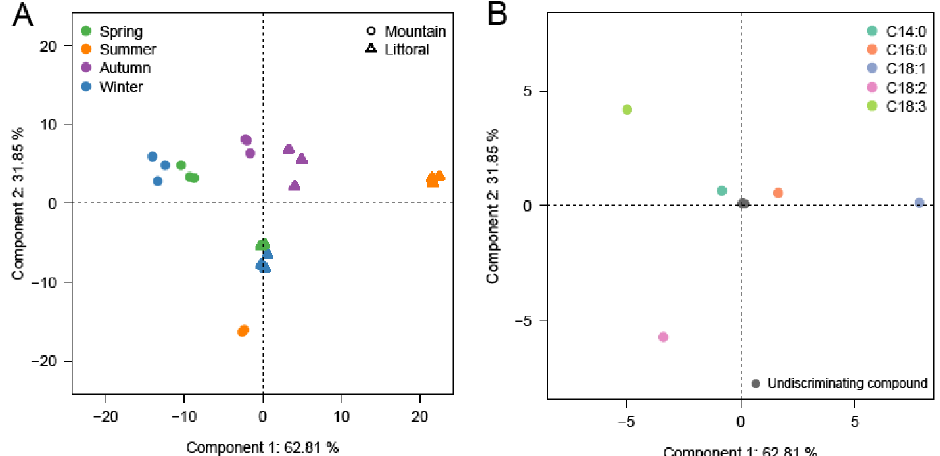
Figure 2. PCA analysis of the FAMEs from the leaf acyl lipids of Pistacia lentiscus leaf samples collected at the two altitude sites ( △ for littoral versus ◯ for mountain) and 4 consecutive seasons: ( A ) score plot of the PC1 versus PC2 scores; ( B ) loading plot of PC1- and PC2-contributing FAME compounds (the most discriminating compounds are represented in color).